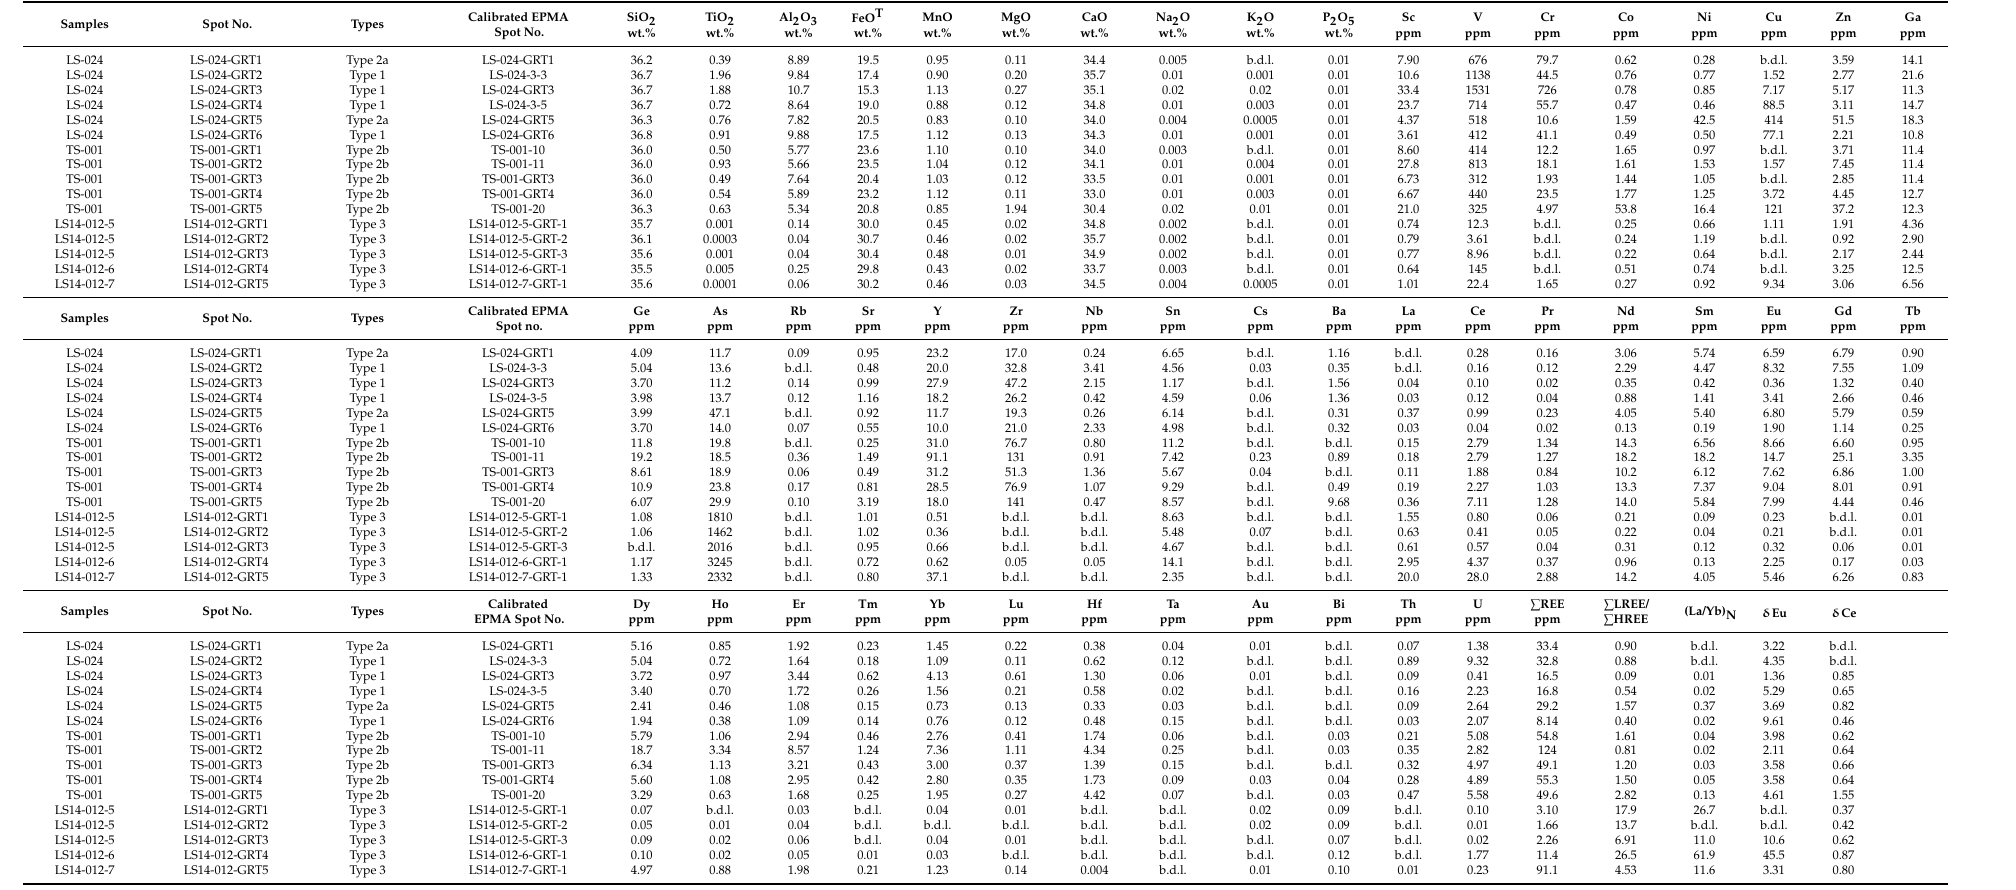
Table 3. LA-ICP-MS major and trace elements data (wt. % and ppm) of garnets from the Laoshankou deposit.